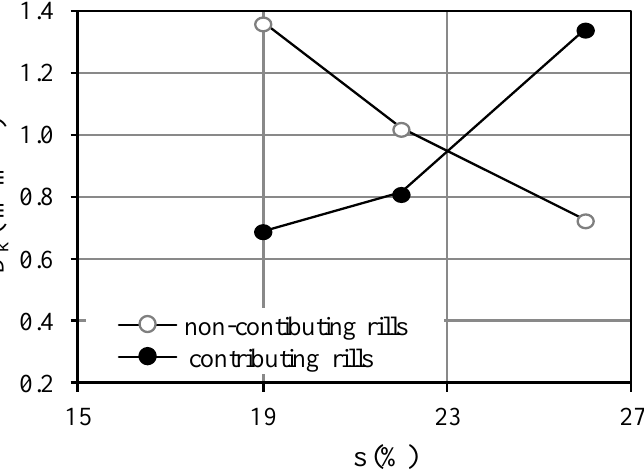
Figure 17. Comparison between the dimensionless power equation and the ( wH / L r,s 2 , V r,s / L r,s 3 ) pairs detected for the plots L (44 m × 8 m), G (33 m × 8 m), and C (22 m × 8 m) using the automatic extraction of the rills (modified from [62]).